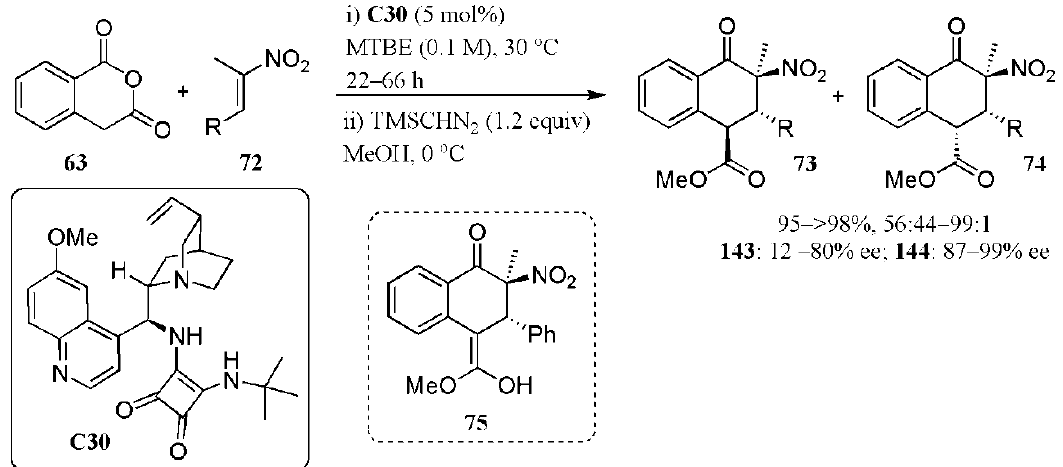
Figure 41. Asymmetric Tamura cycloaddition reaction catalyzed by C30 [80]. The Connon group also showed that a wide range of aldehydes undergoes cycload- dition with homophthalic anhydride ( 63 ) in the presence of organocatalyst C31 to yield substituted lactones 77 in excellent yield and ee s (Figure 42) [81]. In 2016 Rozas, Connon